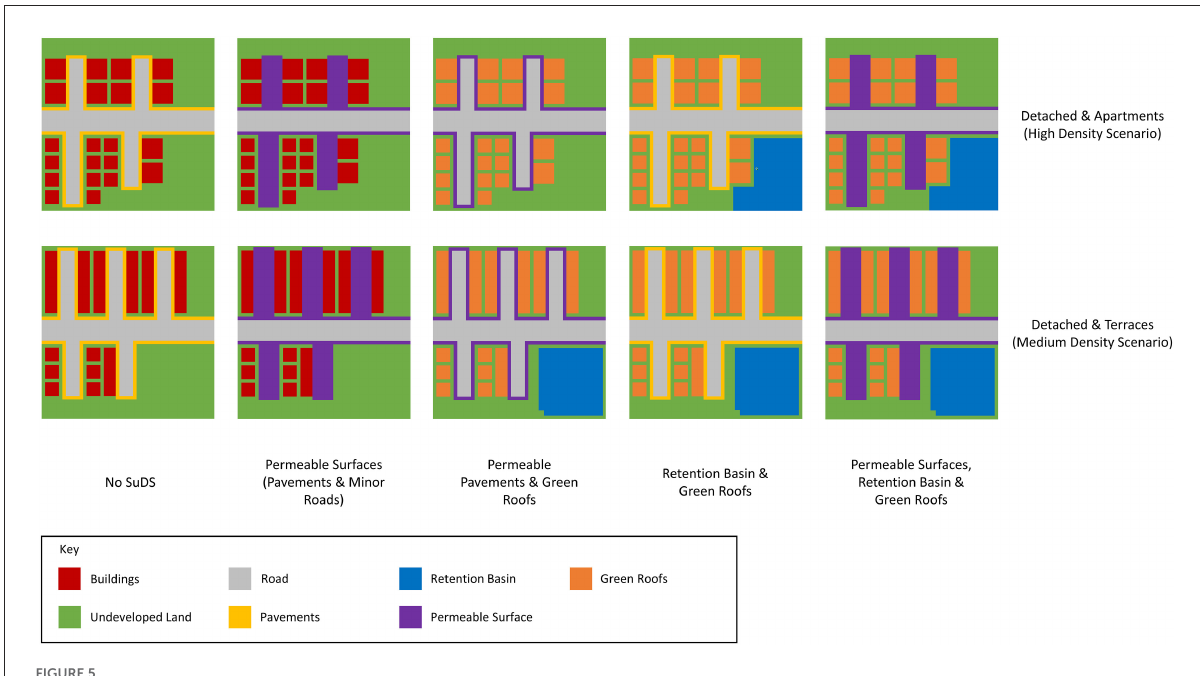
FIGURE5 Example tiles for the five SuDS